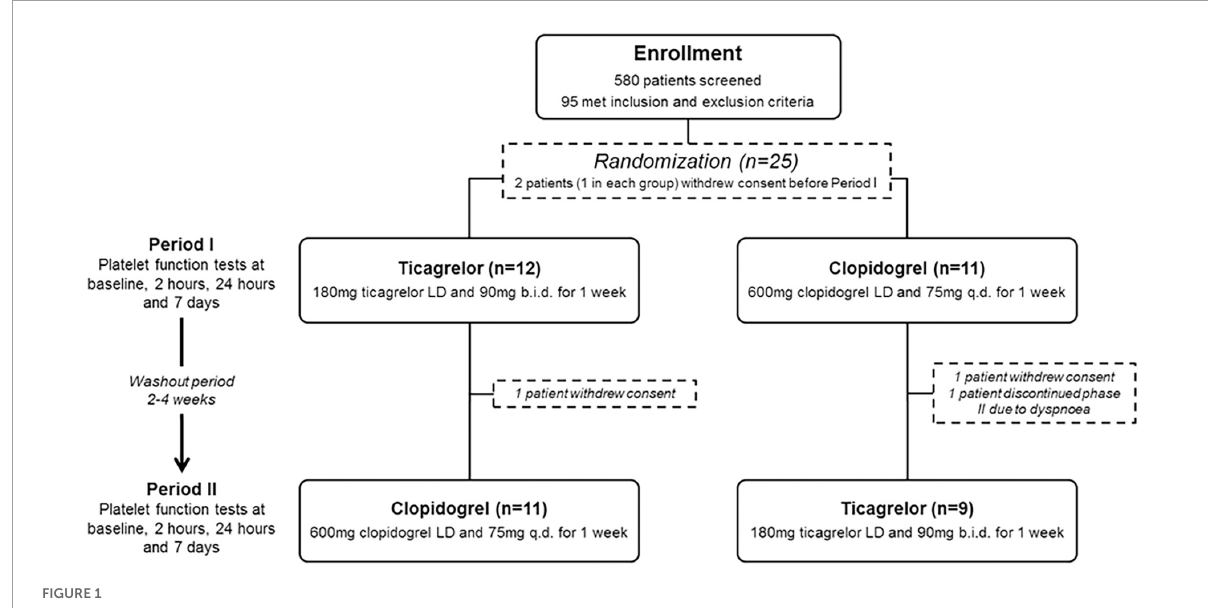
FIGURE1 Flow diagram of the study design and enrollment process. LD, loading dose.